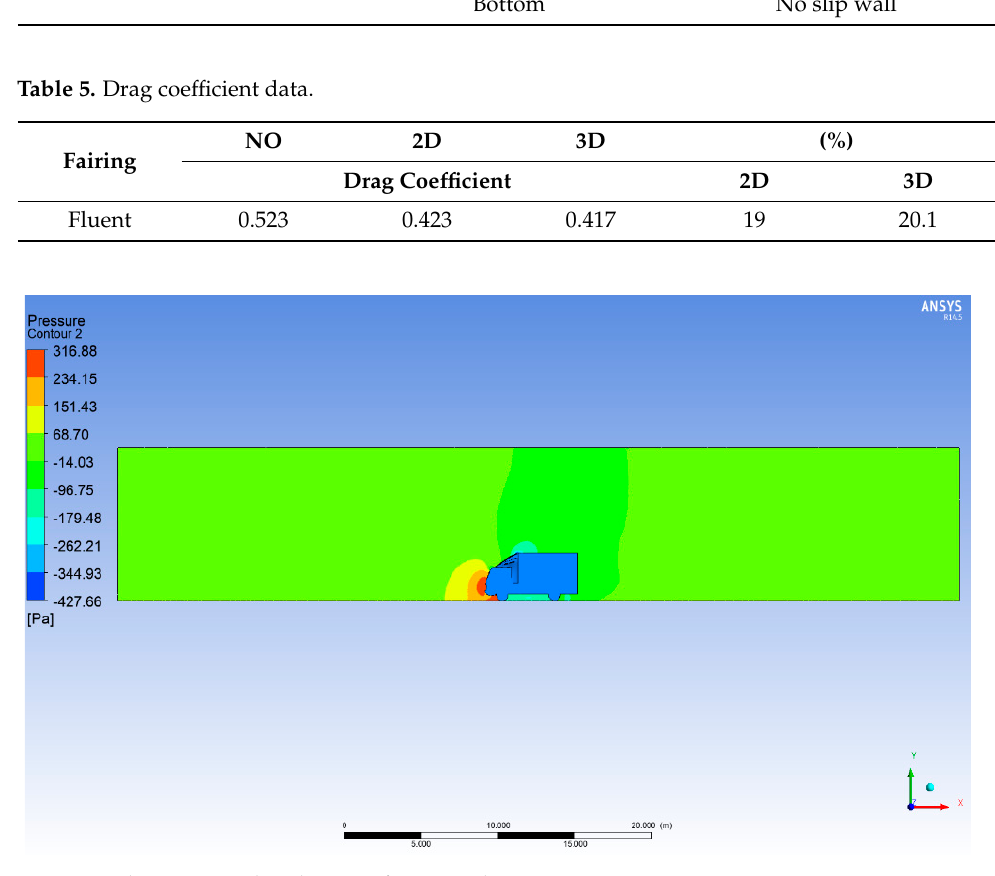
Figure 8. The pressure distribution of CFD